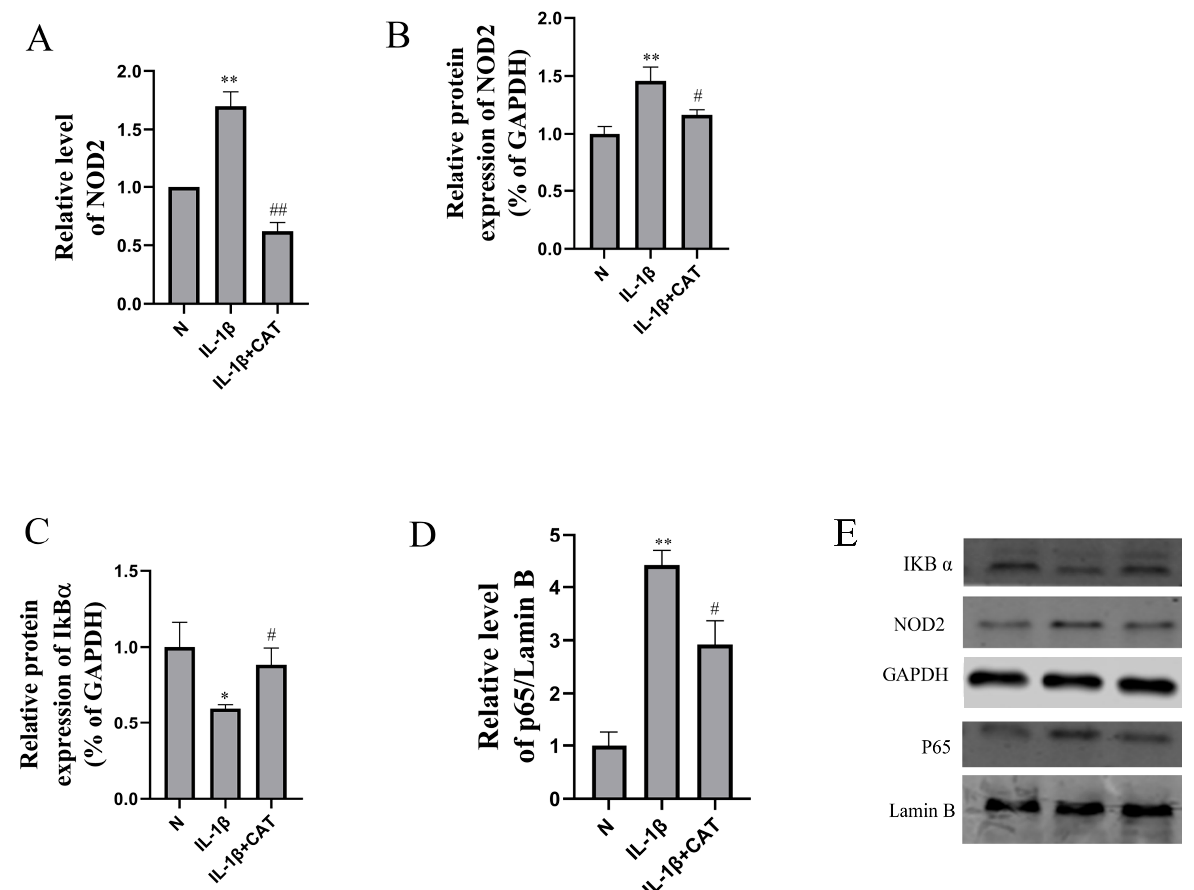
Figure 7. The effects of catalpol on the levels of NOD2, IKB α , and P65. ( A ) NOD2 mRNA level (n = 6); ( B ) NDD2 protein level; ( C ) IKB α protein level; ( D ) P65 protein level ( B – D n = 3); above, densitometric analysis; below, ( E ) representative images of immunoblots. The data are the mean ± S.D. of the mean. * p < 0.05 vs. normal group (N); ** p < 0.01 vs. normal group (N); # p < 0.05 vs. IL-1 β group; ## p < 0.01 vs. IL-1 β group.